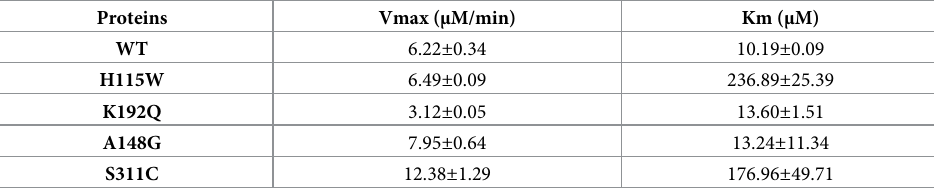
Table 2. Enzyme kinetics for WT and mutant HuPON2 with Phenylacetate as substrate.